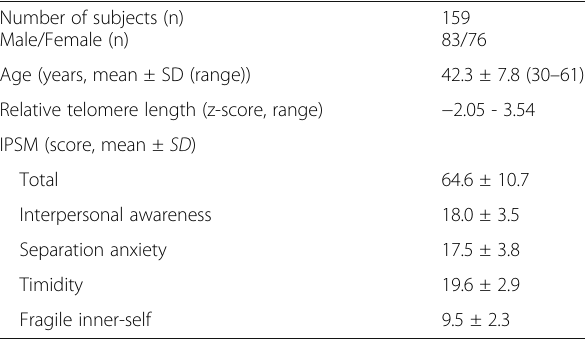
Table 1 Characteristics of subjects, relative telomere length, and IPSM scores Number of subjects (n) 159 Male/Female (n) 83/76 Age (years, mean ± SD (range)) 42.3 ± 7.8 (30 – 61) Relative telomere length (z-score,